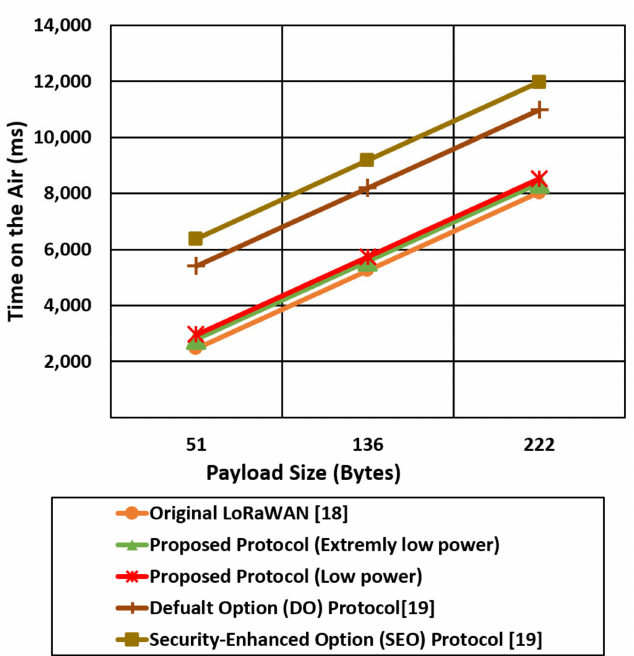
Figure 17. The time on the air comparison for the proposed protocol cases and the other mentioned protocols using the worst-case environment parameters (SF 12).